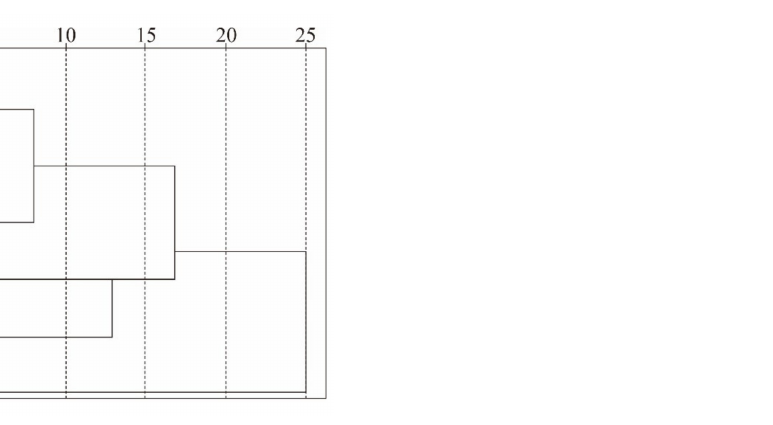
Figure 6. Hierarchical diagrams for the PTEs in obtained soils by the cluster analysis method. Table 5. Potential ecological risk coefficient (E ri ) and potential ecological hazard index (RI) of the studied elements in soils.